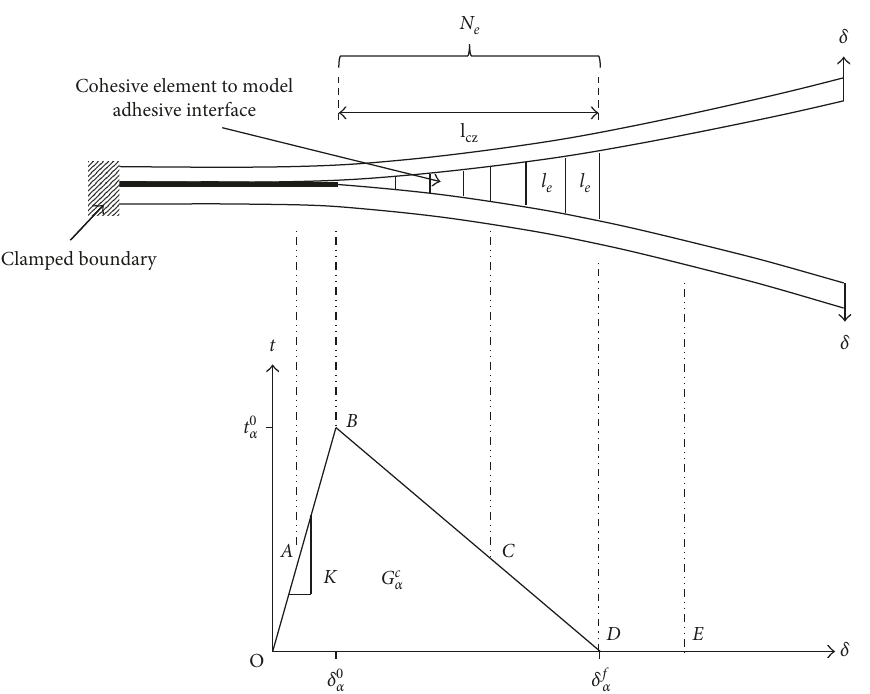
Figure 2: Bilinear traction-separation law for cohesive elements in the DCB